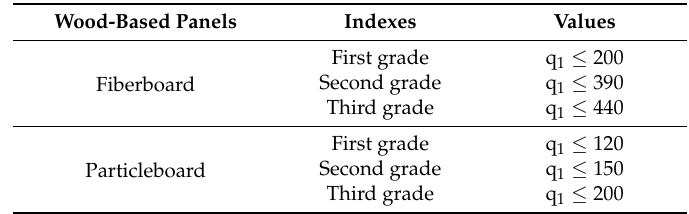
Table 5. Indexes of cleaner production technologies for wood-based panel production in China (kgce/m 3